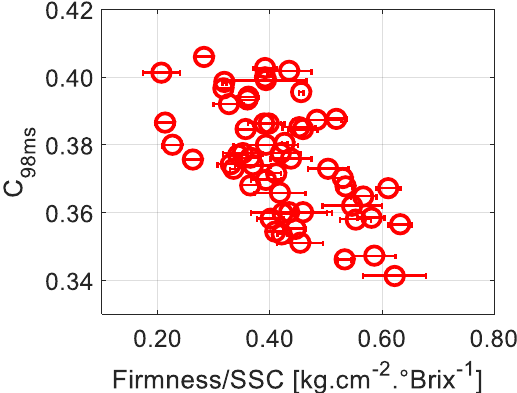
Figure 4. The contrast computed over rings with a 9.2 inner and 9.4 mm outer diameter at an exposure duration of 98 ms ( C 98ms ) as a function of the ratio of the firmness to the SSC level. Horizontal error bars correspond to standard deviations of three different performed firmness measurements.